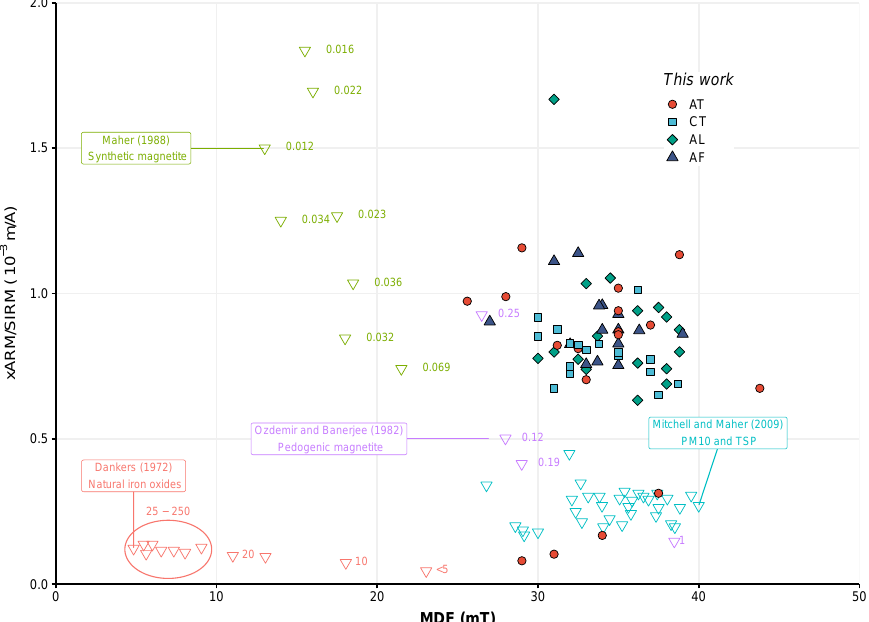
Figure 6. xARM/SIRM versusMDF for selected samples in the four sites (circle-AT, square-CT, diamond-AL, triangle-AF, all filled) and data from Dankers [60], Özden Özdemir and Banerjee [61], Maher [59] and Mitchell and Maher [27] (open inverse triangles in salmon, purple, green and blue re- spectively). Iron oxides reported in Dankers [60], Özden Özdemir and Banerjee [61] and Maher [59] are all composed of synthetic magnetite or ferrimagnetic magnetite-like iron oxides, with known grain sizes (represented by the numbers above the symbols, in µ m). Data from Mitchell and Maher [27] are measurements performed in PM10 filters and leaves (total suspended particles,